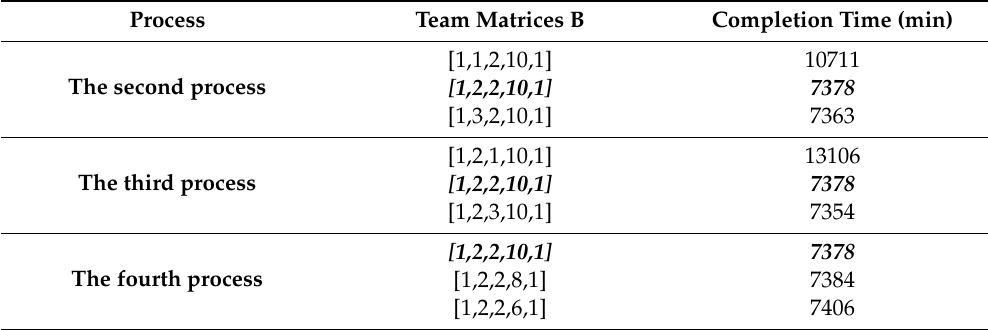
Table 6. Solution results after adjustment and